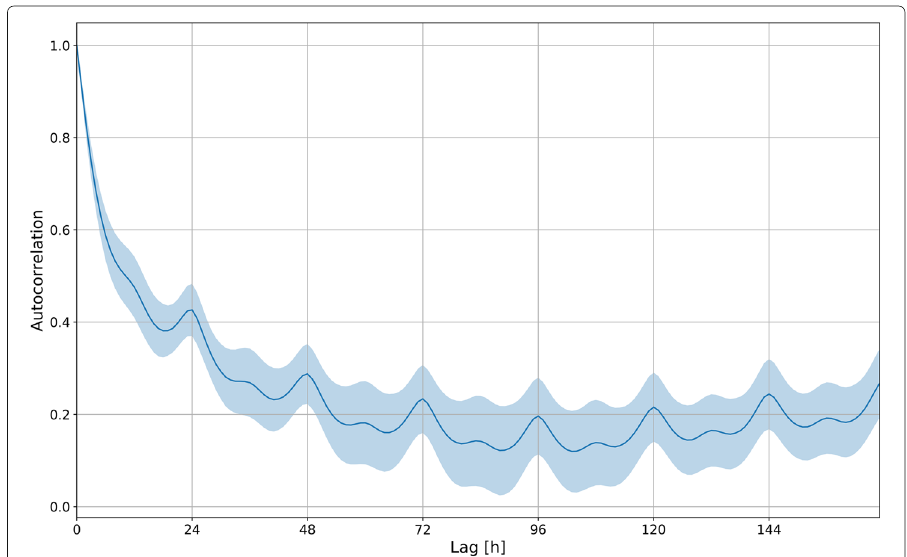
Fig. 3 Autocorrelation of the MAXBEX time series for time lags up to 168 hours (one week). The blue line depicts the average over all links, the shade the corresponding standard deviation